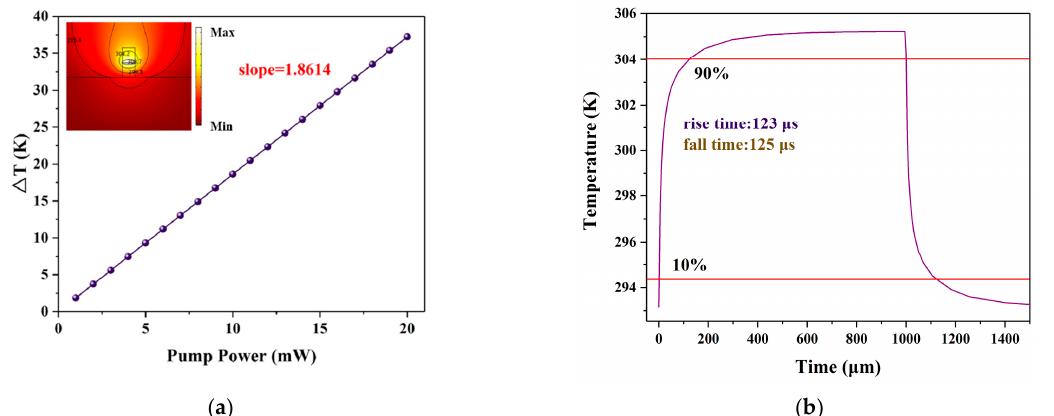
Figure 7. Switching characteristics without silicon substrate. ( a ) The relationship between waveguide temperature variation and pump power; ( b ) time response of optical switch.